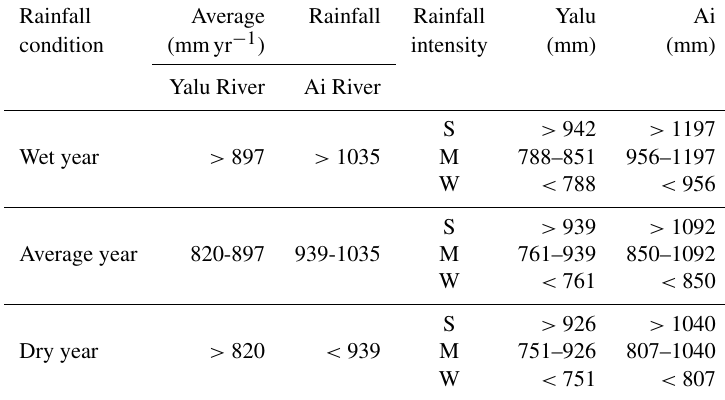
Table A2. Different rainfall conditions (wet, average, and dry years) and rainfall forms (strong, moderate, and weak) for the Yalu and Ai